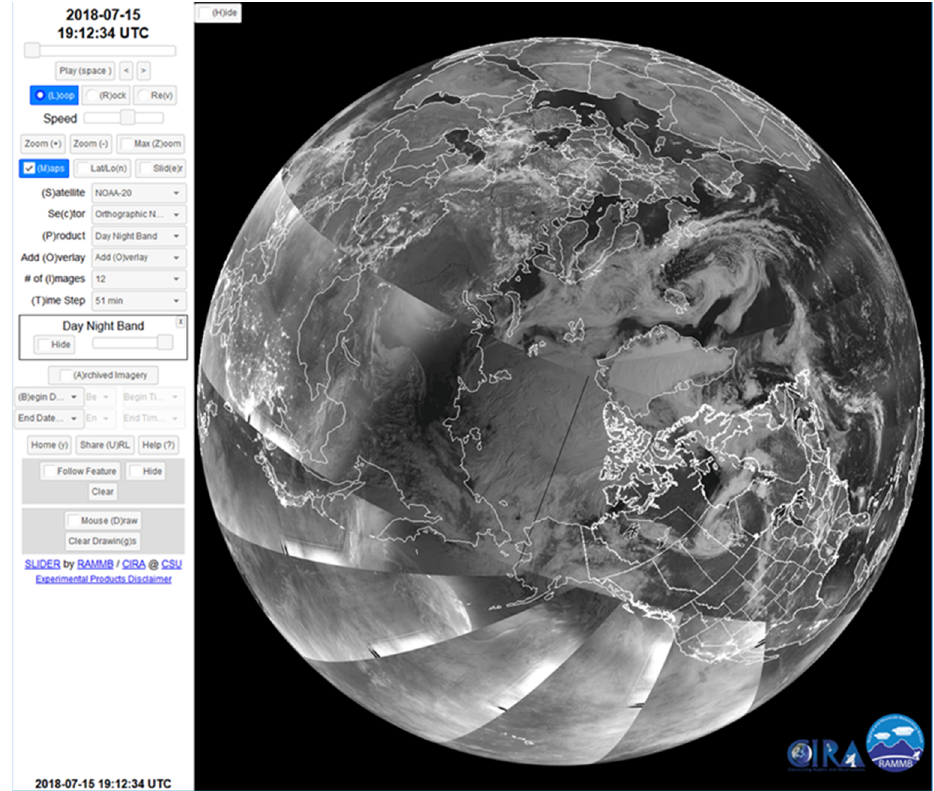
Figure 10. A Polar SLIDER display of DNB Imagery centered on the North Pole. This example has bright stray light intrusions at the edges of the swaths, which occur in the extended granule portion of the NOAA-20 DNB. The control panel at the left allows the display of all of the VIIRS bands as well as several VIIRS imagery products.